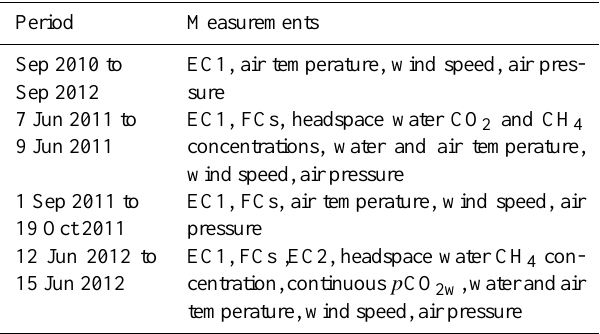
Table 1. Summary of measurements during different